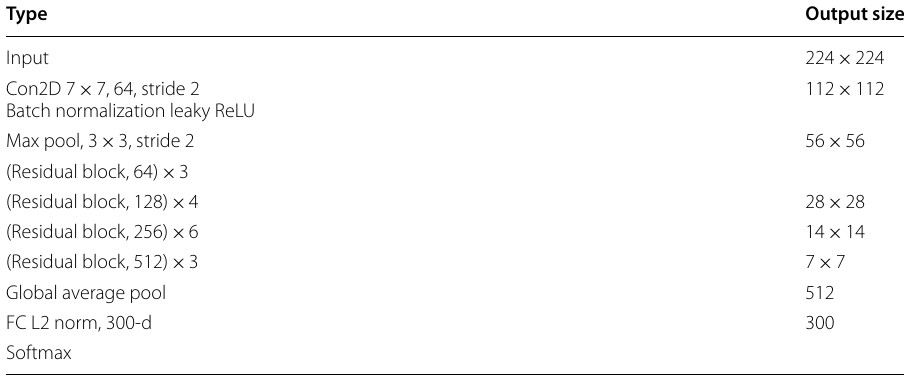
Table 1 MFR‑Net V1 network